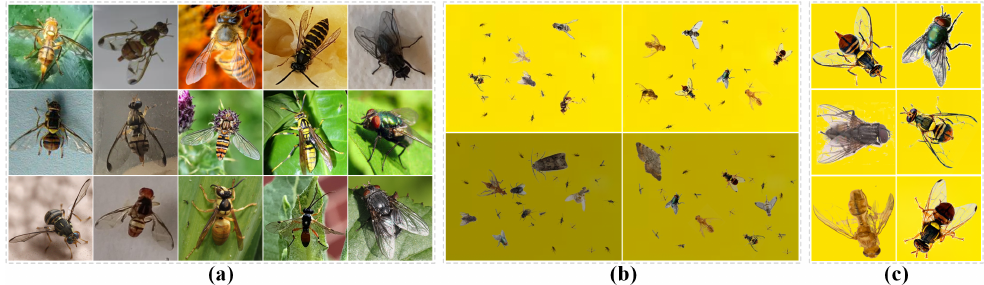
Figure 5. ( a ) The main insect species are possibly stuck on the e-trap and their categories infor- mation is described in Appendix A.1. ( b ) The simulated yellow paper images for e-trap’s auto- control and insect detection. ( c ) The synthesized and cropped insect images for validating the recognition